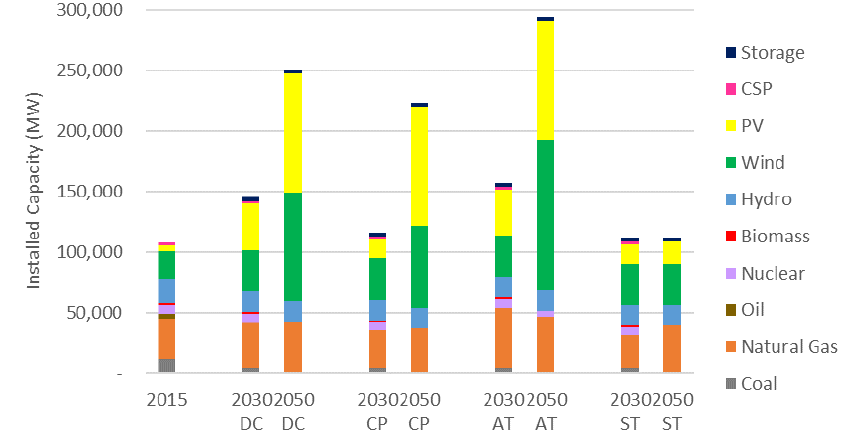
Figure 5. Projections of installed capacity and technology mix in Spain (2030–2050) compared to reference year 2015.